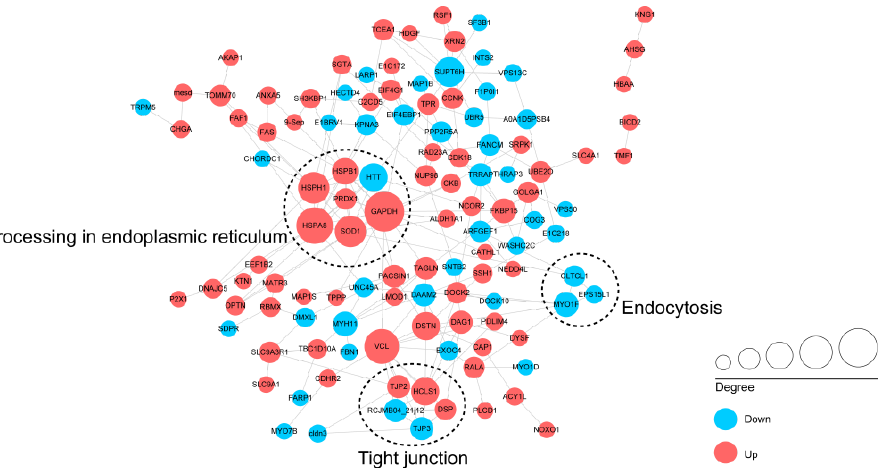
Figure 6. The PPIs networks of the identified DPPs. Red and blue indicate up- and down-regulated DPPs, respectively. The larger the circle, the more interaction nodes.